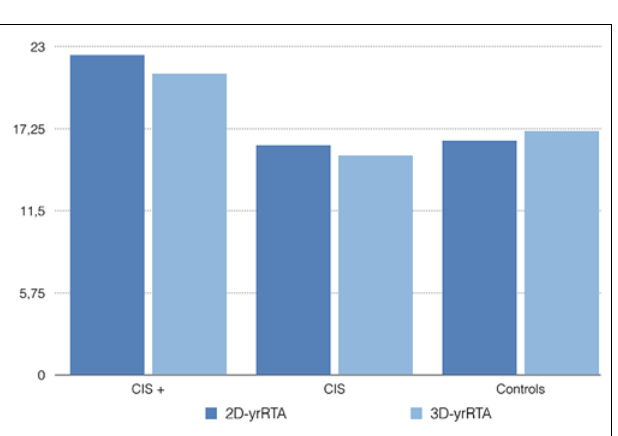
FIGURE 2 | Mean 2D- and 3D-yrRTA in patients with CIS who converted to MS over 24 months (CIS +), CIS who not converted (CIS) and healthy controls. Values are merely illustrative -not